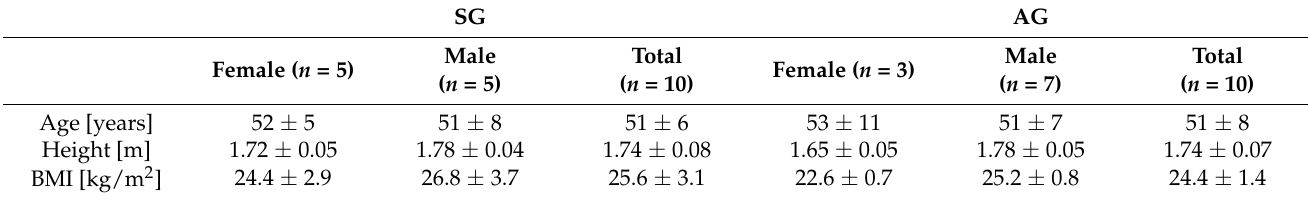
Table 1. Sex- and group-specific baseline characteristics (MW ± SD) of the participants.